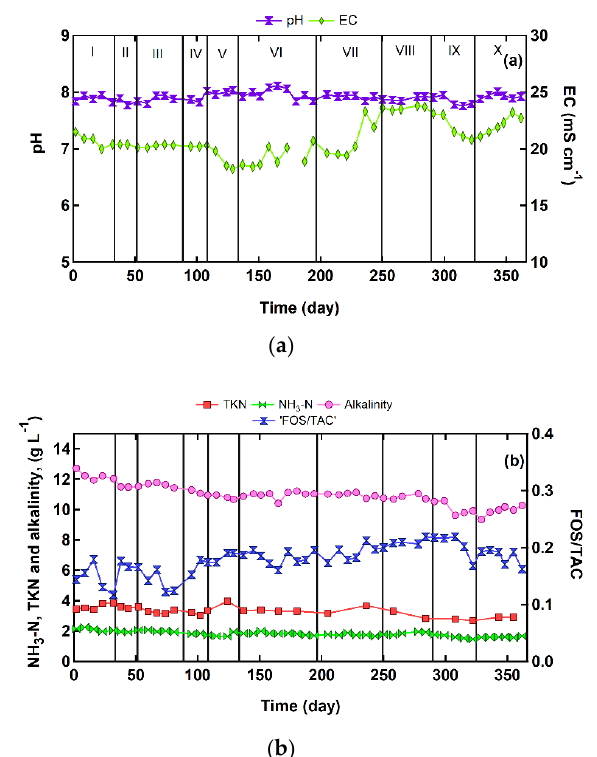
Figure 5. ( a ) pH and electrical conductivity (EC) values, and ( b ) NH 3 -N, TKN, alkalinity concentration and FOS/TAC during the whole operating period of the full-scale